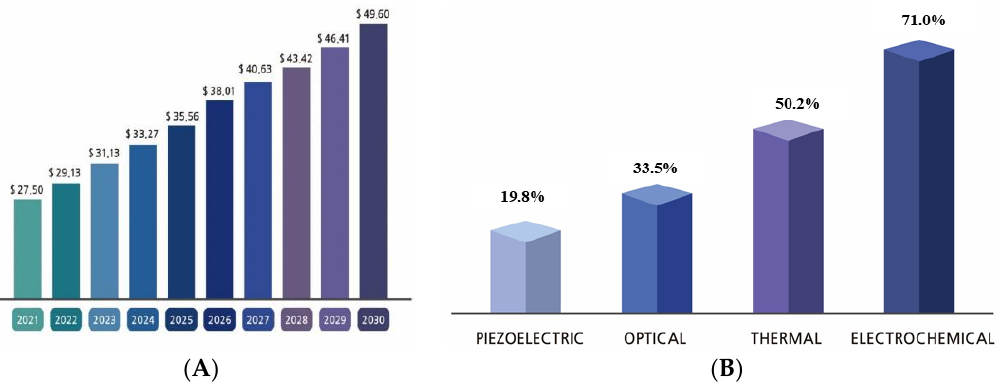
Figure 1. The world market in biosensors. ( A ) Biosensor market size; ( B ) Types of biosensors in industrial market share [1].